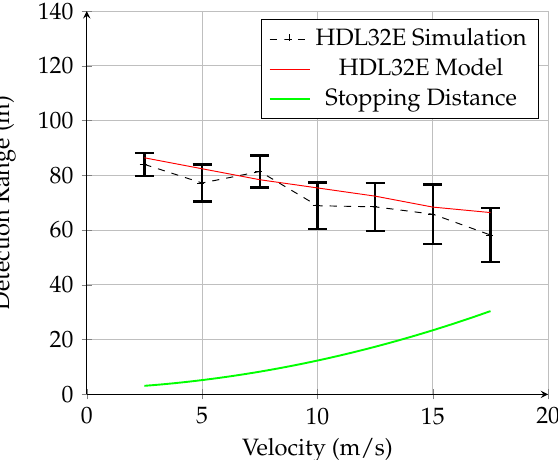
Figure 8. Results for the UAV-mounted HDL-32E sensor. The red line is the analytical model, the black line is the simulation, and the green line is the stopping distance.